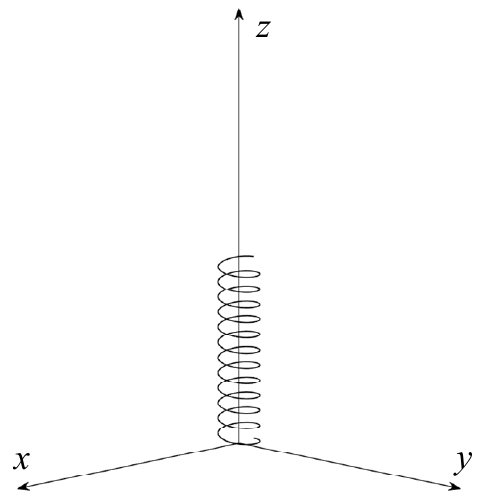
Table 1. The parameter of helical antenna.